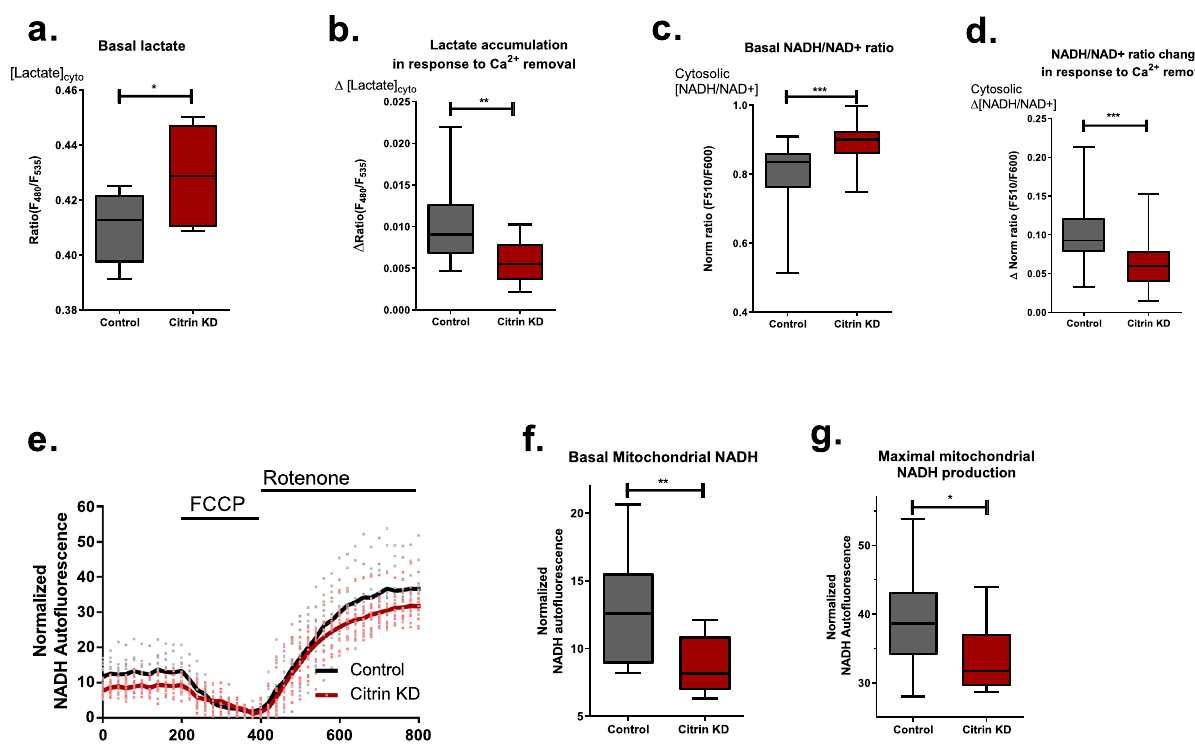
Fig. 5 Citrin KD mimics the metabolic alterations happening during basal Ca 2 + drop condition. a Basal cytosolic lactate levels of control vs Citrin KD in